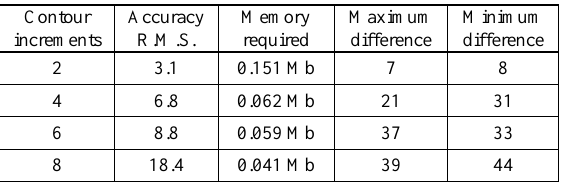
reconstruct the original image o increments between 2 and 8 grey-s